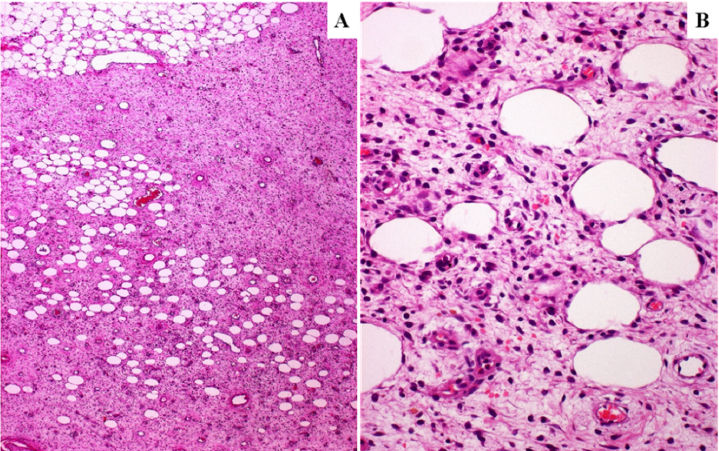
Figure 1. Primary DAM. Low ( A ) and high ( B ) power magnifications showing entrapment of adipose tissue.